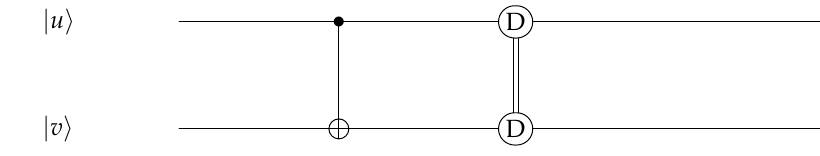
Figure 2. Quantum circuit of M z operator when applied on two qubits u and v , where u is the control qubit and v is the target